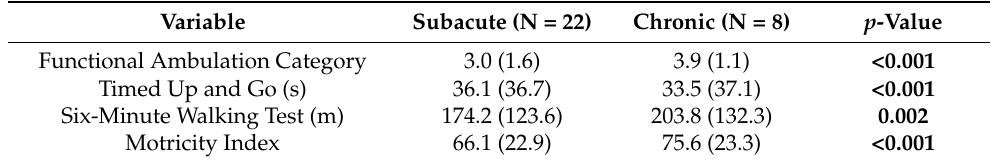
Table 2. Clinical assessment before (T0) and after the rehabilitation treatment (T1) for the two investigated groups. p -values refer to the Wilcoxon Sign Rank Test. Values in bold indicate a statistically significant difference between T0 and T1 ( p <